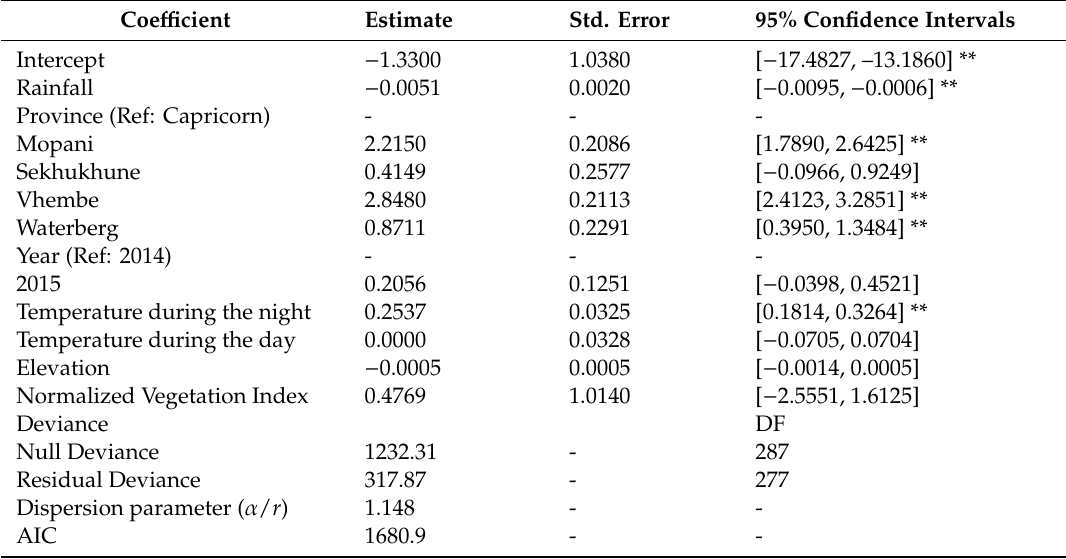
Table 4. Parameter estimates for negative binomial (NB) model under classical approach encompassing all the variables.